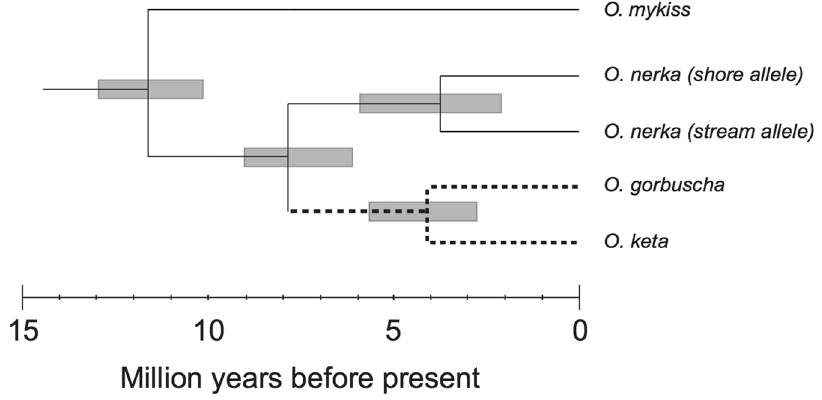
Figure 4. Time to most recent common ancestor for the shore- and stream-spawning alleles in LRRC9 as derived from BEAST 64 . All other divergence timings are based on a previously published molecular clock 41